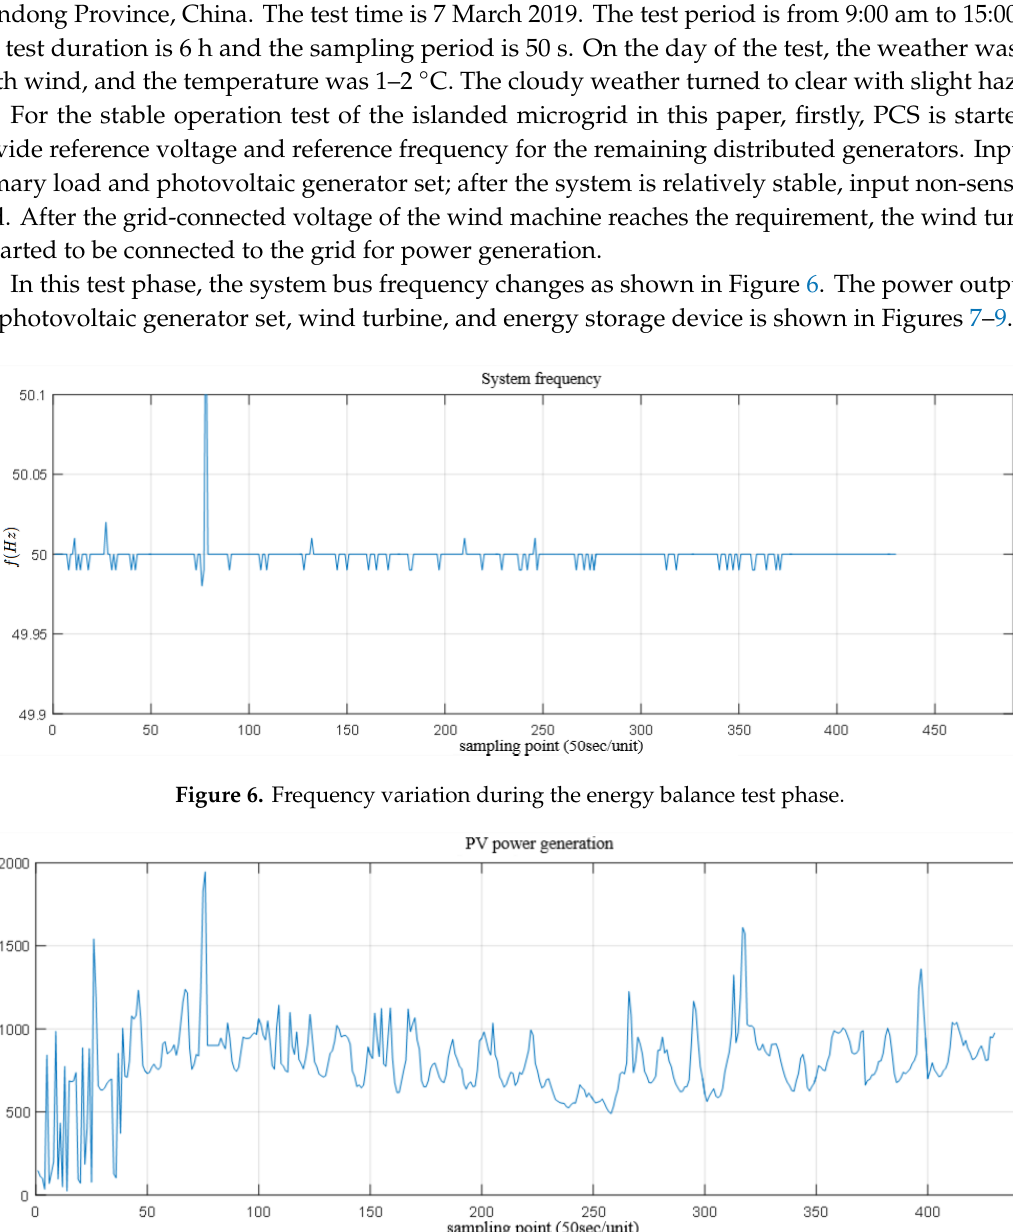
Figure 7. Photovoltaic power and energy deployment.